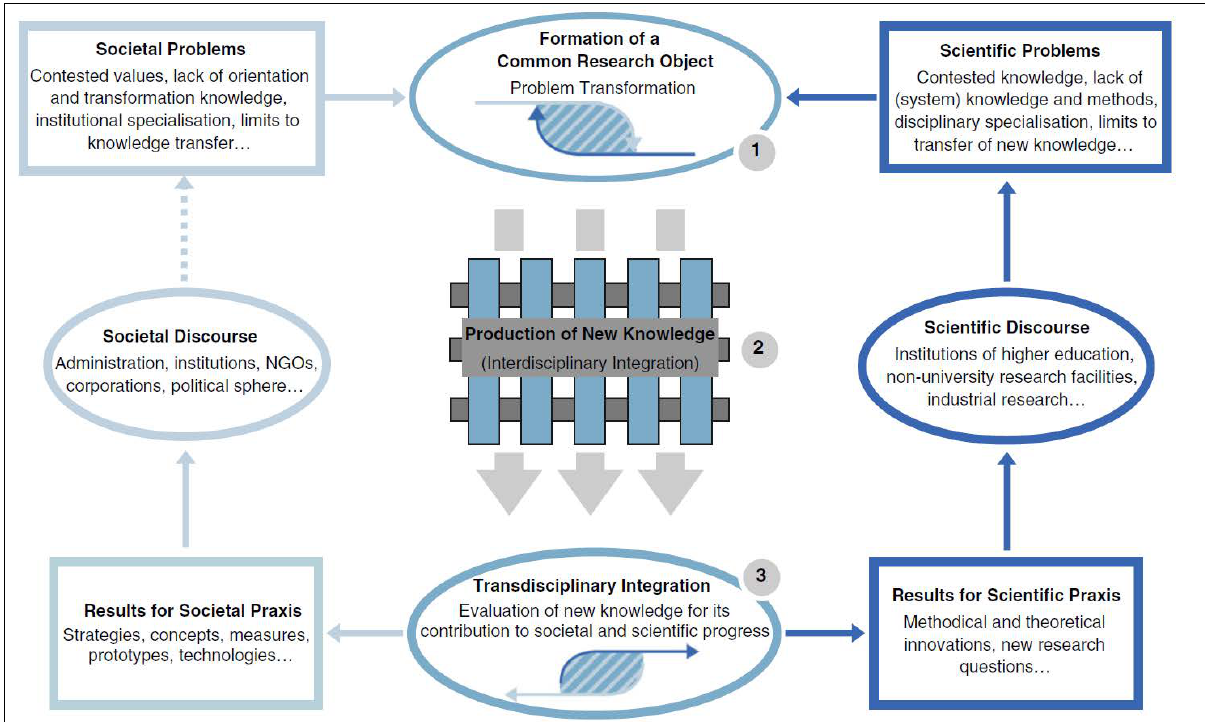
Figure 1: Conceptual model of an idealised transdisciplinary research process.